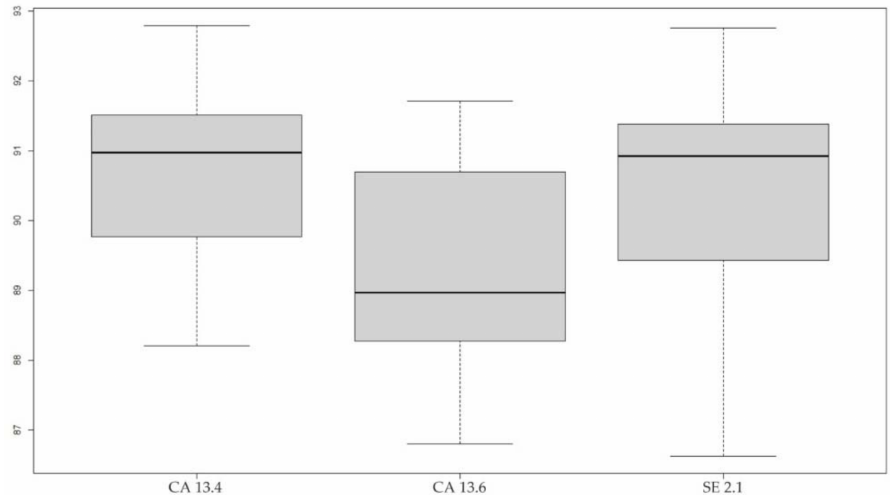
Figure 7. Box-plot representations showing the distribution of J index values in cultivars CA 13-4, CA 13-6 and SE 2-1 with the Sylvestris model.